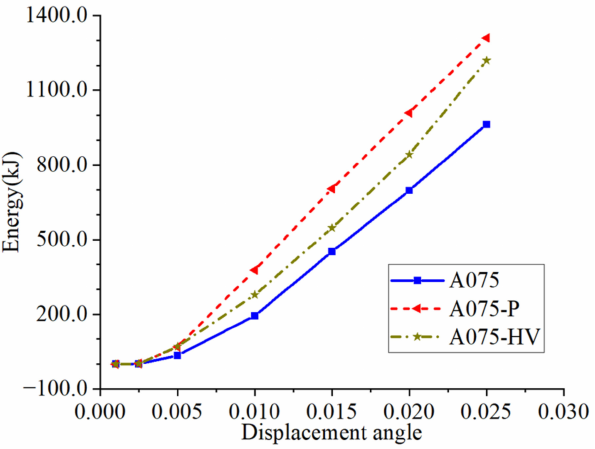
Figure 18. Energy dissipation of different